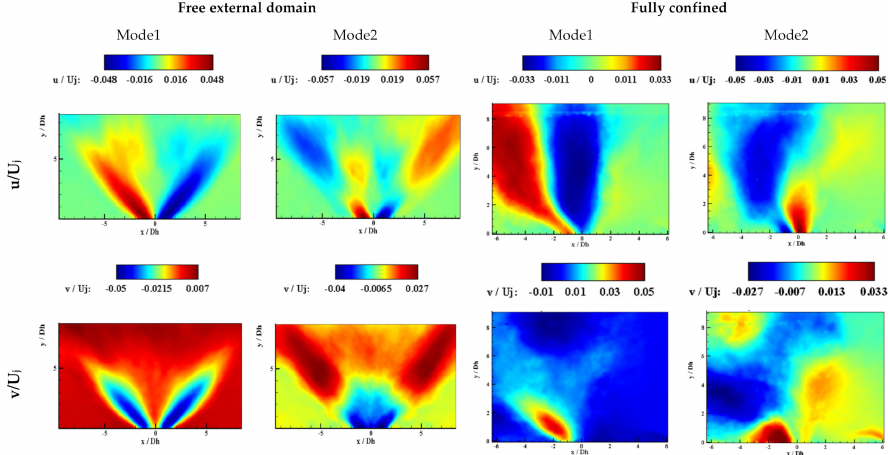
Figure 15. Spatial patterns of the POD modes for the both free and fully external domains at Re =